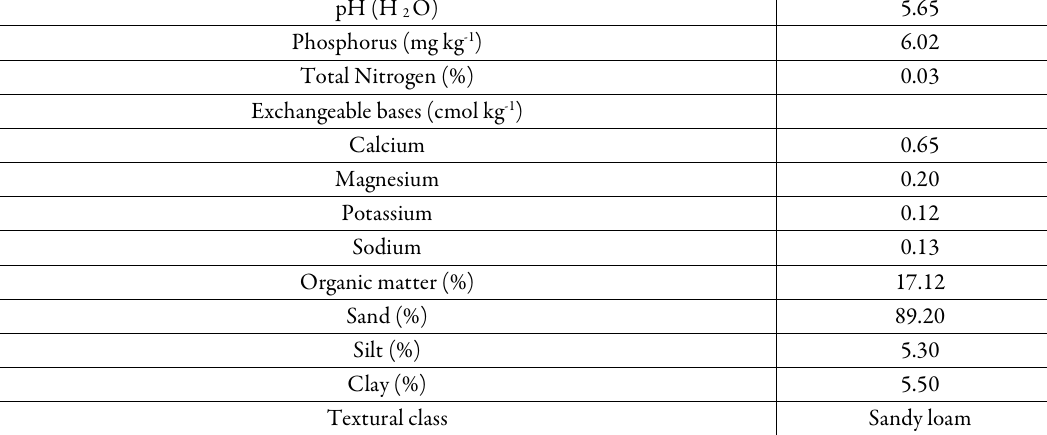
Table 1. Physico-chemical composition of soil from experimental site pre